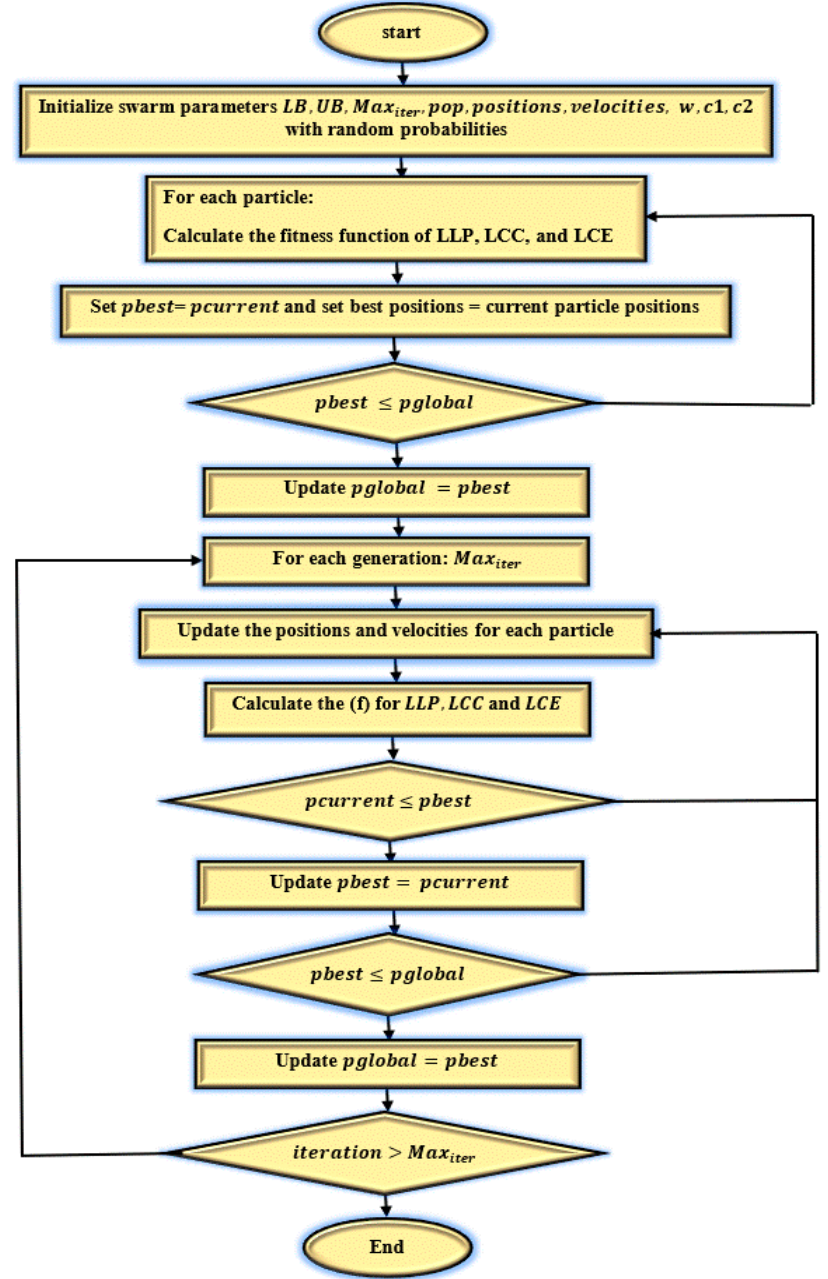
Figure 4. Flow chart of the proposed optimal sizing of SAPV system using AW / SFPSO cf method. Step 1: initialization